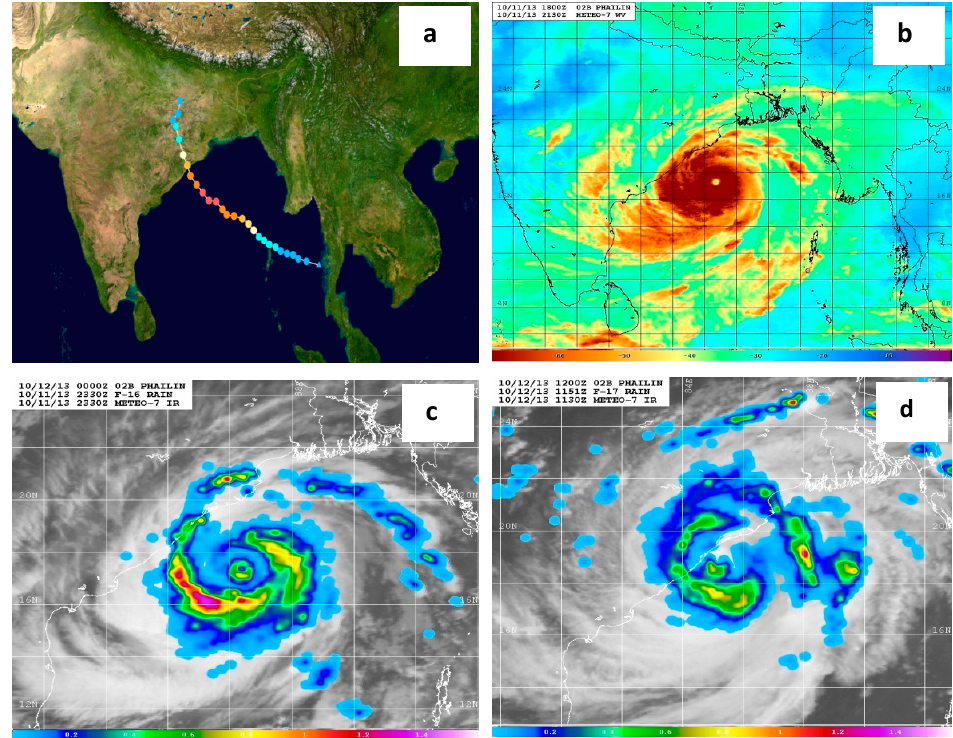
Figure. 1 (a) Track of Phailin during 8-13 October 2013; according to SSHWS, the system Figure 1. ( a ) Track of Phailin during 8–13 October 2013; according to SSHWS, the system became equivalent to a Category 5 became equivalent to a Category 5 (NASA) on 00 UTC 12 Oct, 2013; Satellite images METEO (NASA) on 00 UTC 12 October 2013; Satellite images METEO 7 of ESCS Phailin, ( b ) water vapor 00 UTC 12 October 2013, 7 of ESCS Phailin (b) water vapor 00 UTC 12 Oct, 2013 (c) rain rate valid on 11 Oct, 2013 at ( c ) rain rate valid on 11 October 2013 at 23:30 UTC, ( d ) rain rate after landfall valid on 13 October 2013 at 11:30 UTC shown 23:30 UTC (d) rain rate after landfall valid on 13 Oct, 2013 at 11:30 UTC shown double double eyewall features [for details https://rammb-data.cira.colostate.edu/tc_realtime/, (accessed on 21 August eyewall features[for details https://rammb-data.cira.colostate.edu/tc_realtime/].